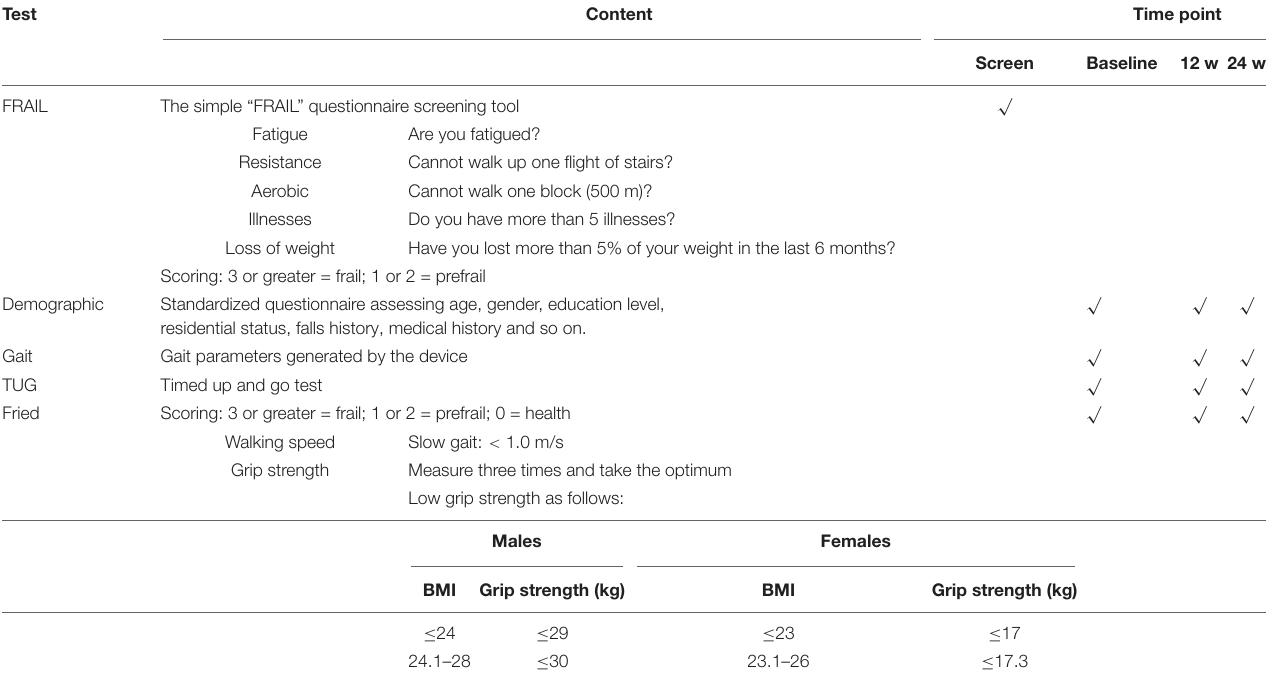
TABLE 3 | Indicators collected and assessment tools at each time point.